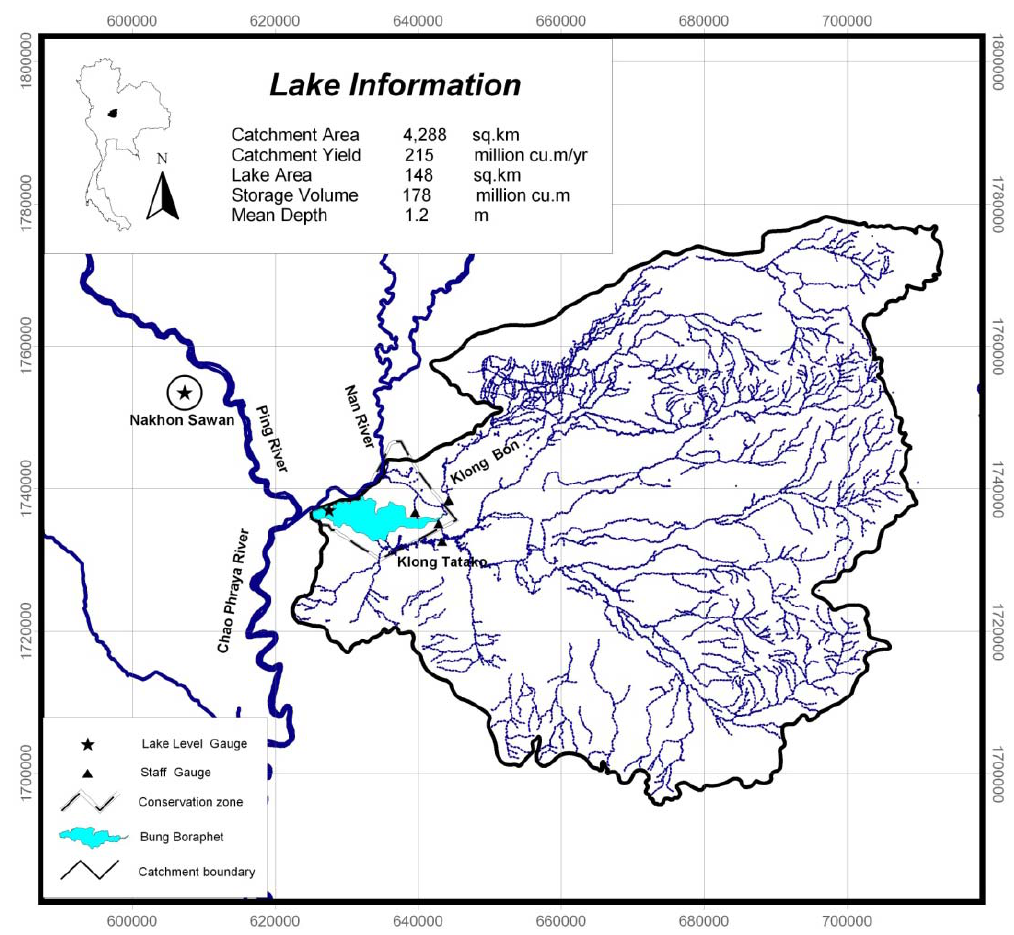
Figure 1. Location, dry season catchment and instrumentation for Bung Boraphet study (dashed line delineates the Conservation Zone around Bung